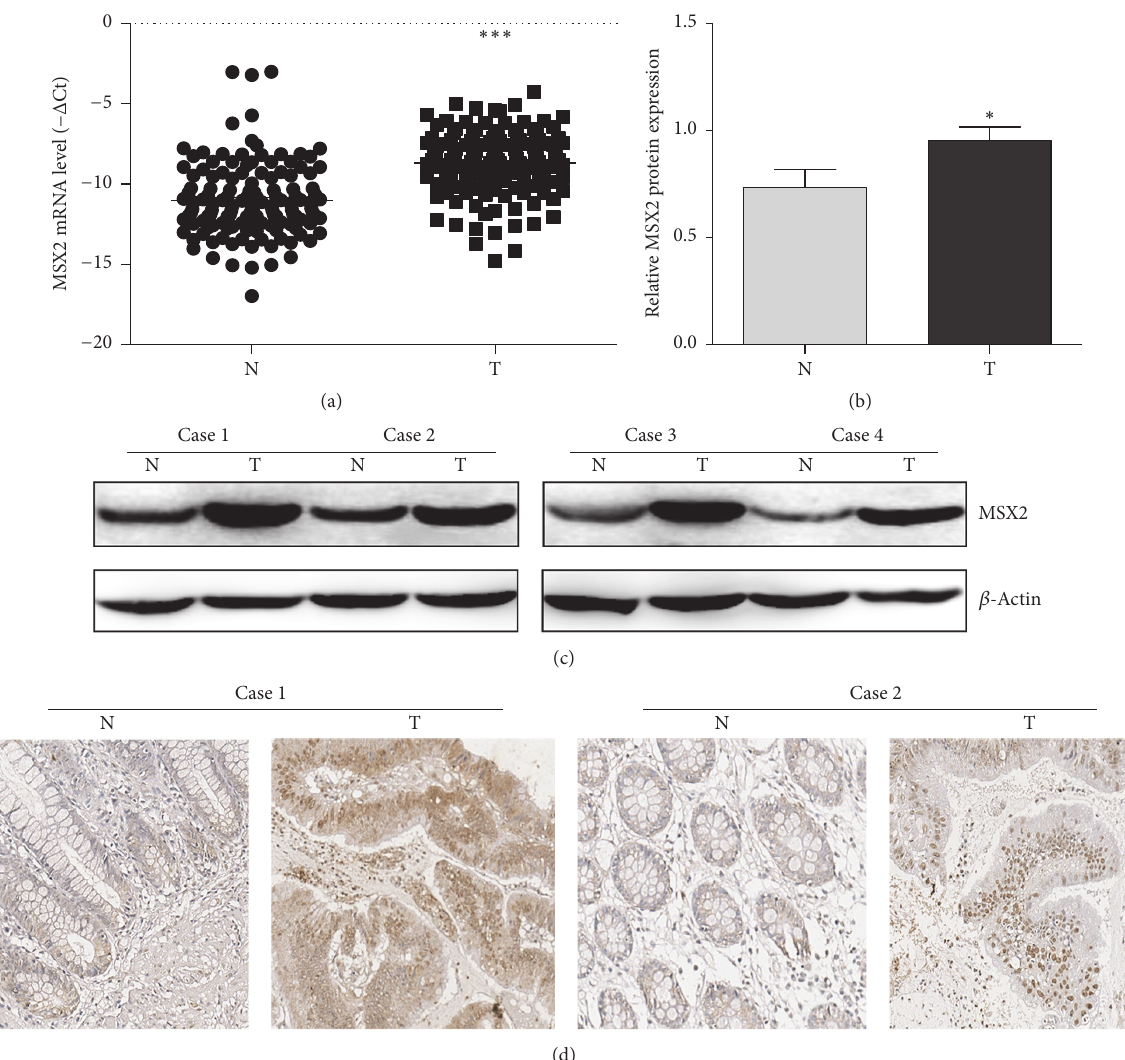
Figure 1: The expression of MSX2 in CRC tumor tissue (T) and adjacent tissue (N). (a) The MSX2 expression of T and N in 136 CRC patients was determined by qRT-PCR ( ∗∗∗ 𝑃 < 0.001 , 𝑛 = 136 ). Lower Δ Ct value indicates higher MSX2 expression ( Δ Ct = CtMSX2 − Ct 𝛽 - actin). (b) The protein expression of MSX2 of T and N was determined by western blotting ( ∗ 𝑃 < 0.05 , 𝑛 = 10 ). The MSX2 expression was normalized to 𝛽 -actin. (c) Representative western blotting analysis of MSX2 expression in T and N and 𝛽 -actin was used as a loading control. (d) Representative immunohistochemical analysis of MSX2 expression in T and